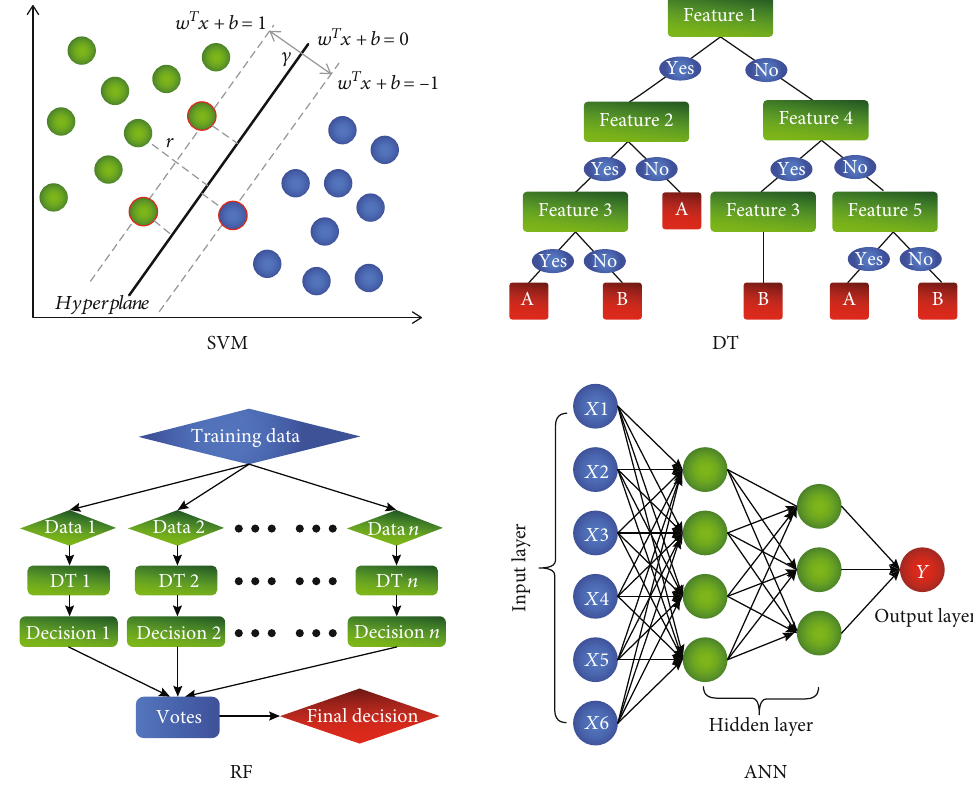
Figure 2: Diagrams of the commonly used machine learning algorithms in neuroimaging studies. SVM: support vector machine; DT: decision tree; RF: random forest; ANN: arti fi cial neural